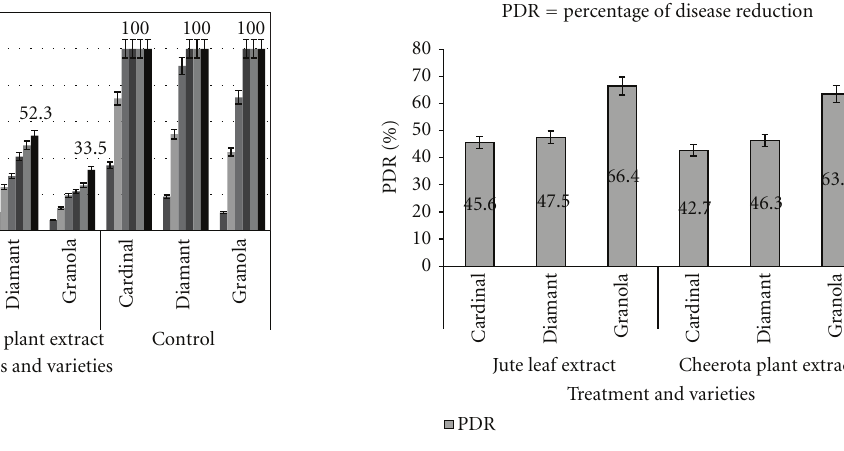
Figure 5: E ff ect of two botanical extracts on percentage of disease reduction (PDR) of potato after 22 weeks of inoculation in storage condition. Table 2: In vitro evaluation of antibacterial activity of dried jute leaf extract and cheerota plant extract against potato soft rot bacteria ( E. carotovora subsp . Carotovora P-138).